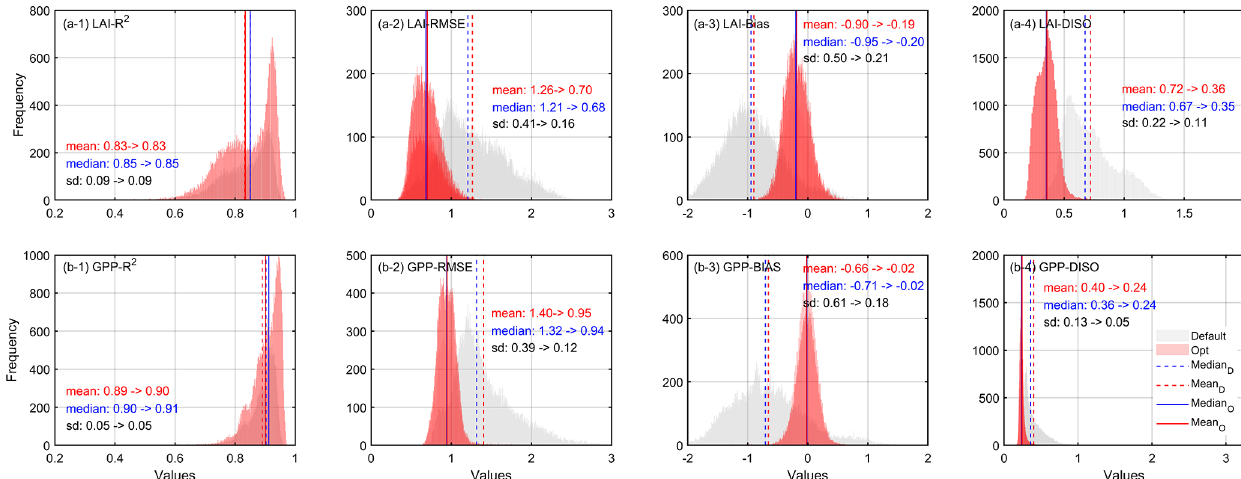
Figure 8. Histogram error statistics of LAI and GPP by running prior and posterior parameter